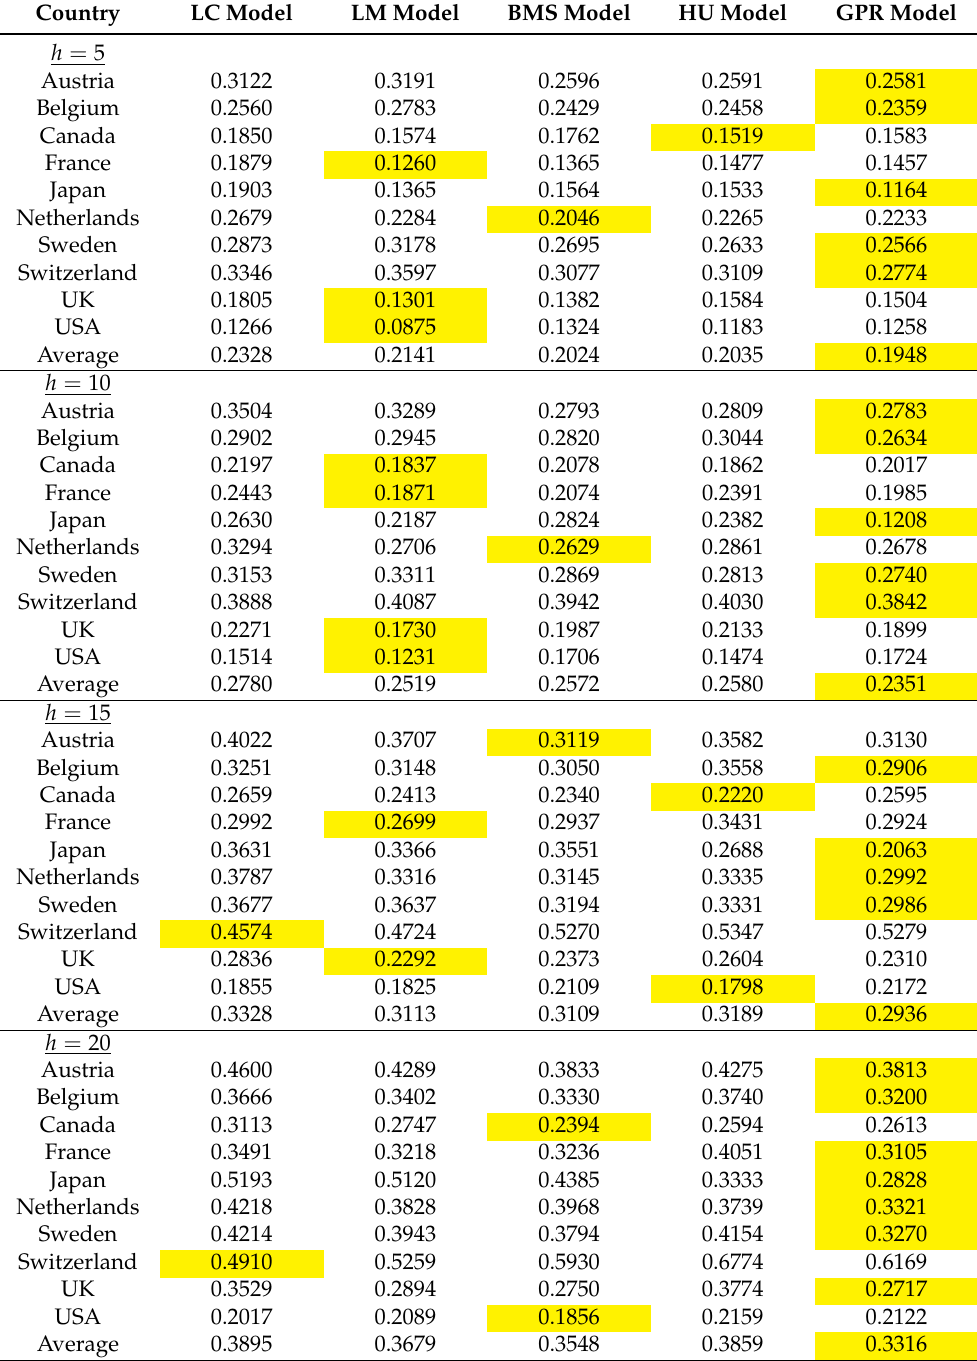
Table 1. The average RMSEs of ten sets of rolling-window analysis on the predicted male mortality curves using the LC model, the LM model, the BMS model, the HU model and the GPR model. The lowest forecast errors among all the models are